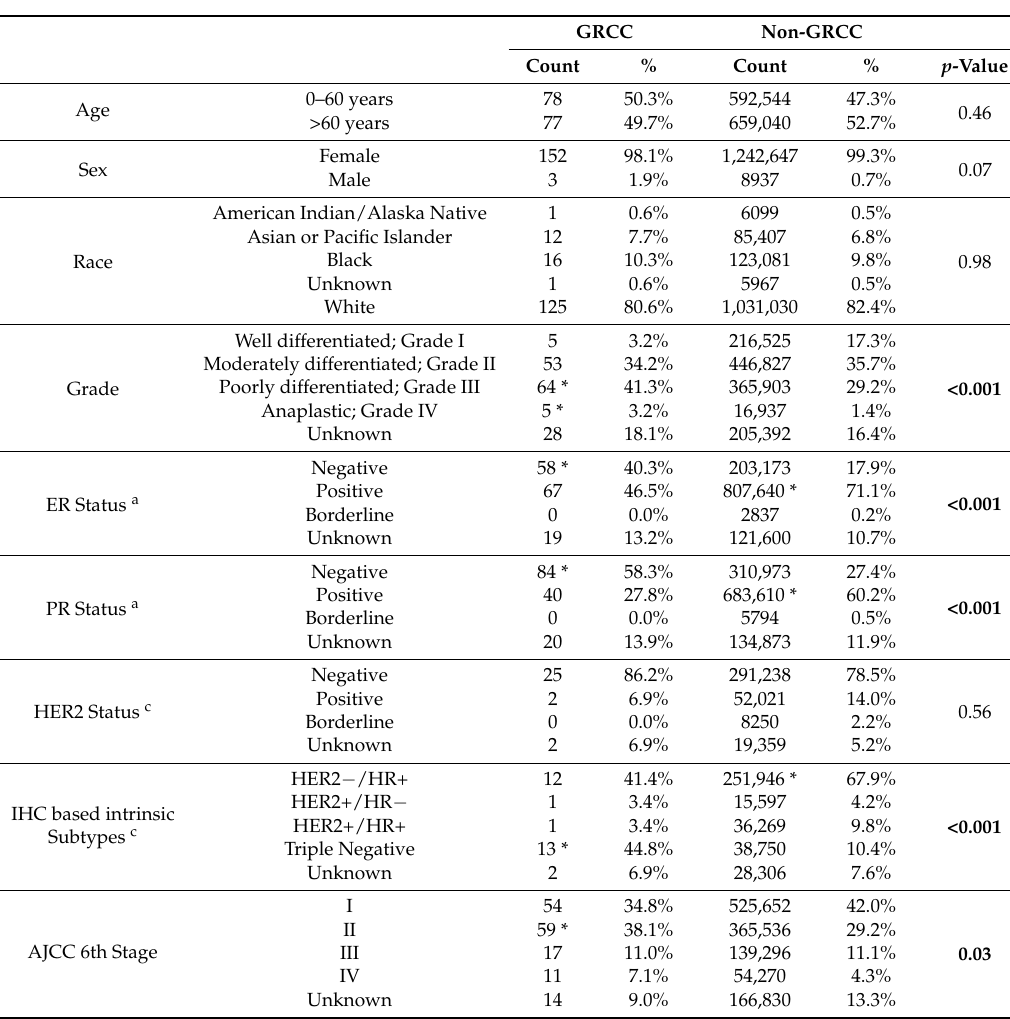
Table 1. Demographical and clinical